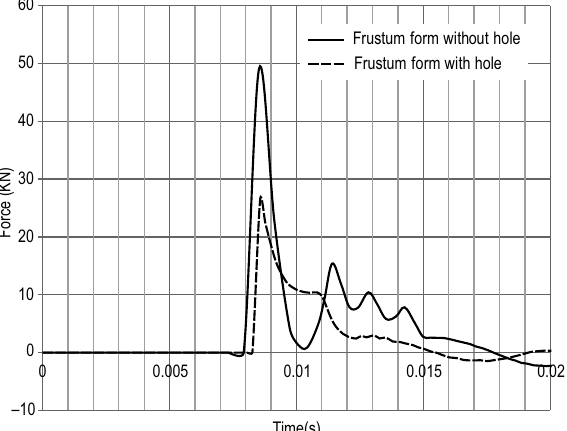
Fig. 25. The comparison of frustum with the hole and free of hole (explosion in the middle of the